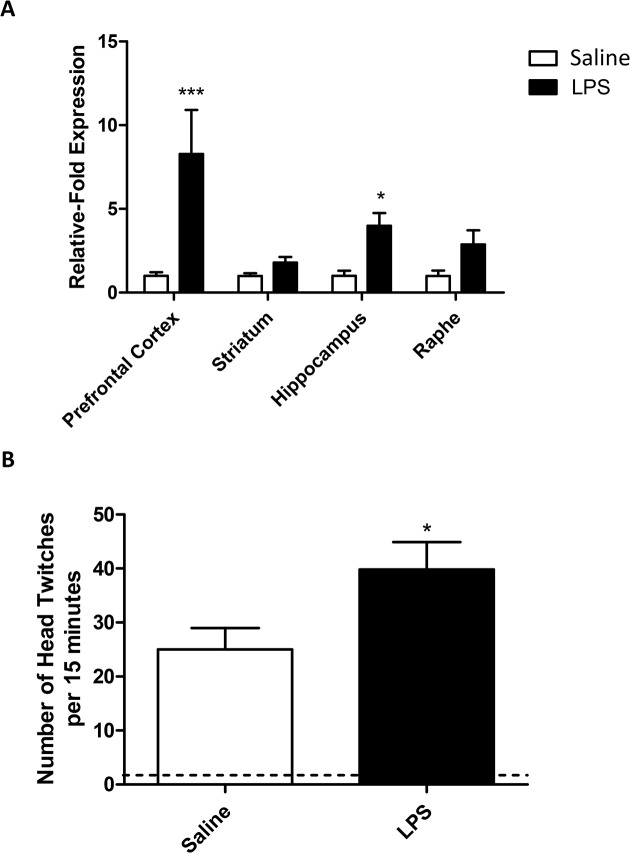
5-HT2A receptor changes after LPS.mRNA expression in the CNS 24 hours after an LPS challenge (A), mRNA levels are expressed as relative-fold expression compared to saline controls within each region. mRNA expression is normalized to the housekeeping gene GAPDH prior to analysis. LPS-induced changes in 5-HT2A-mediated head-twitch responses (B). Animals received a single dose of LPS (0.5mg/kg i.p.) and were allowed to recover for 24 hours prior to receiving a single dose of DOI (1mg/kg i.p.). Head twitch behaviours were observed over a period of 15 minutes. Dotted line represents baseline (no DOI) data for both LPS and saline treated animals. Data are mean ±SEM n = 6; *p<0.05, **p<0.01 and ***p<0.001 compared to saline injected controls.